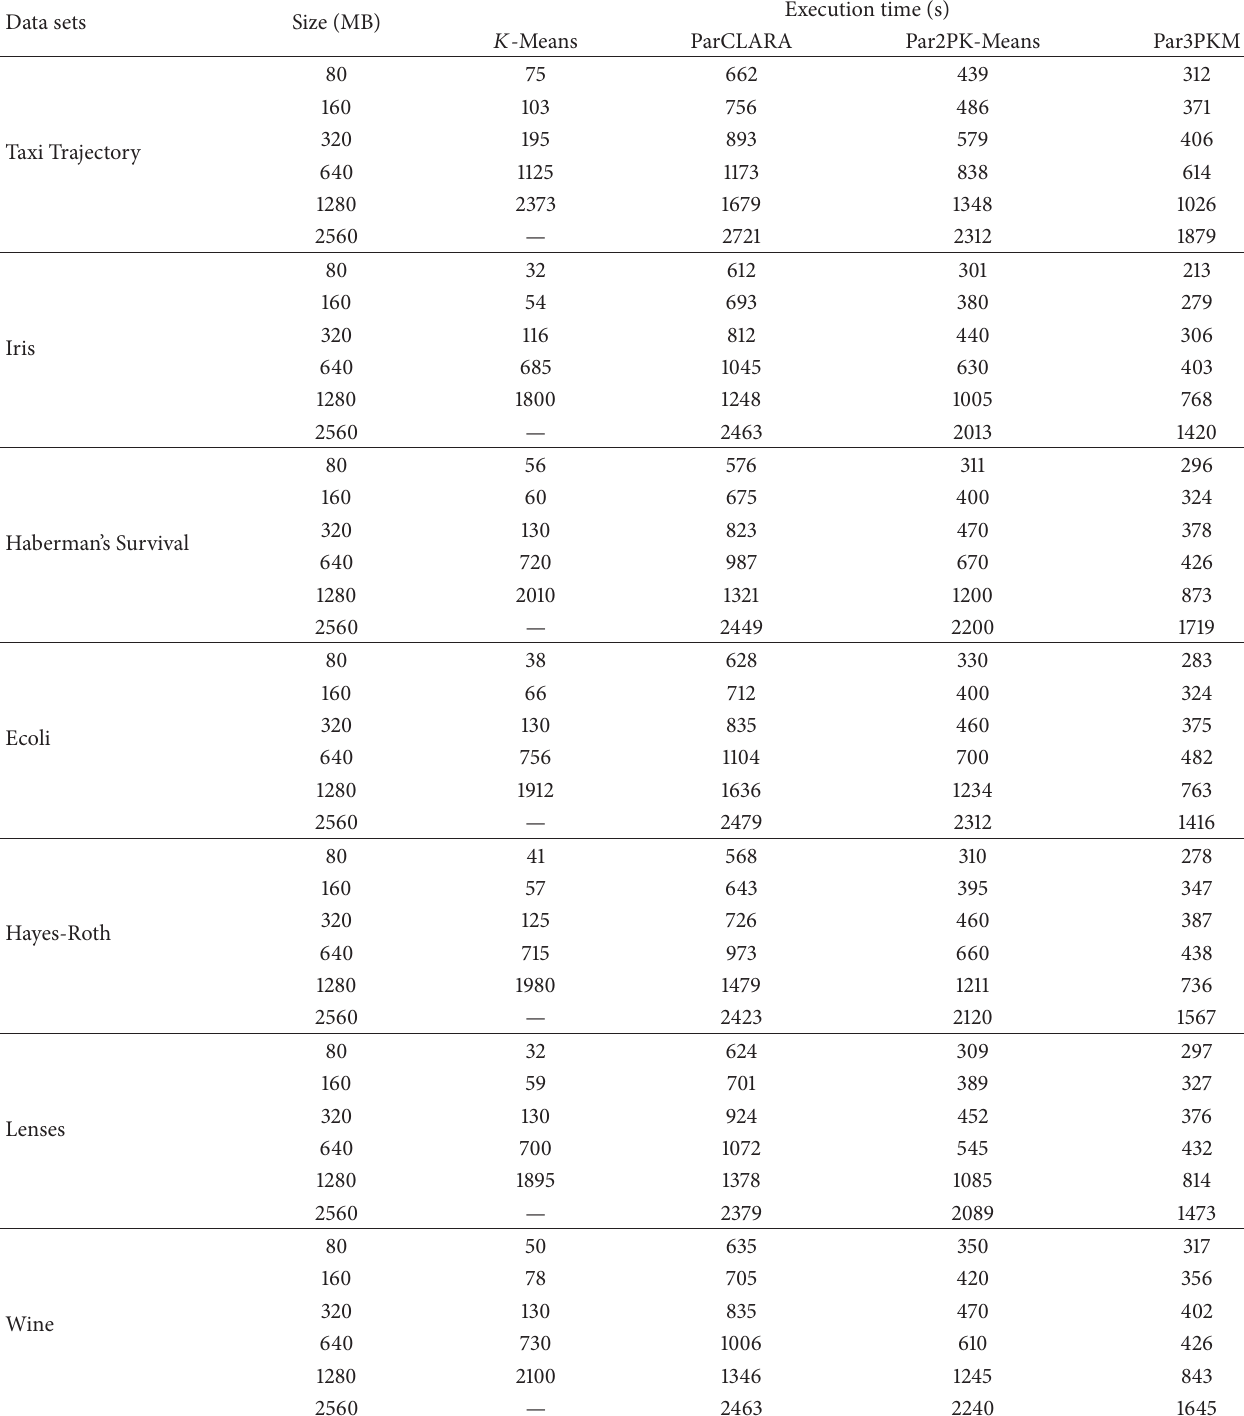
Table 2: Execution time comparison on seven data